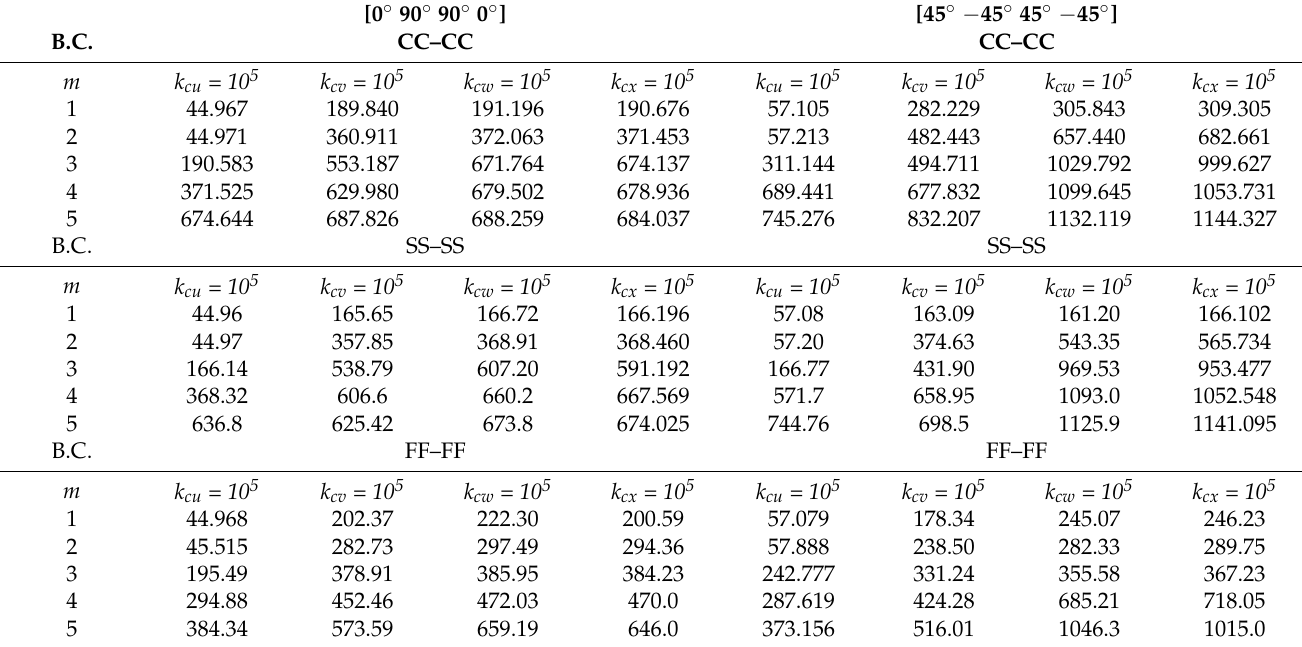
Table 3. Influence of coupling relationship on vibration frequency of LCDCSS.